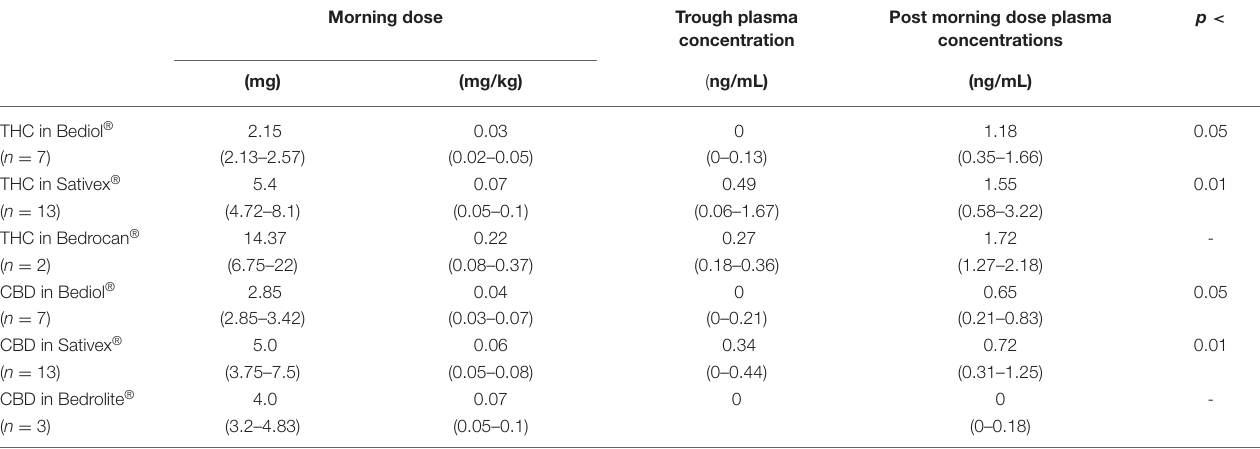
TABLE 2B | Cannabinoids morning doses, matched trough and post-dosing plasma concentrations in a subset of patients by different cannabis-based oral formulations. Morning dose Trough plasma Post morning dose plasma concentration concentrations